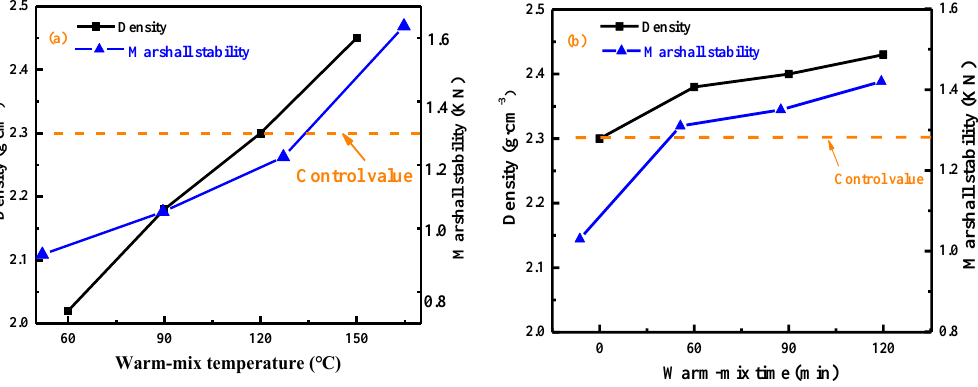
Figure 16. Influence of curing temperature and time on density and Marshall stability of recycled mortars.